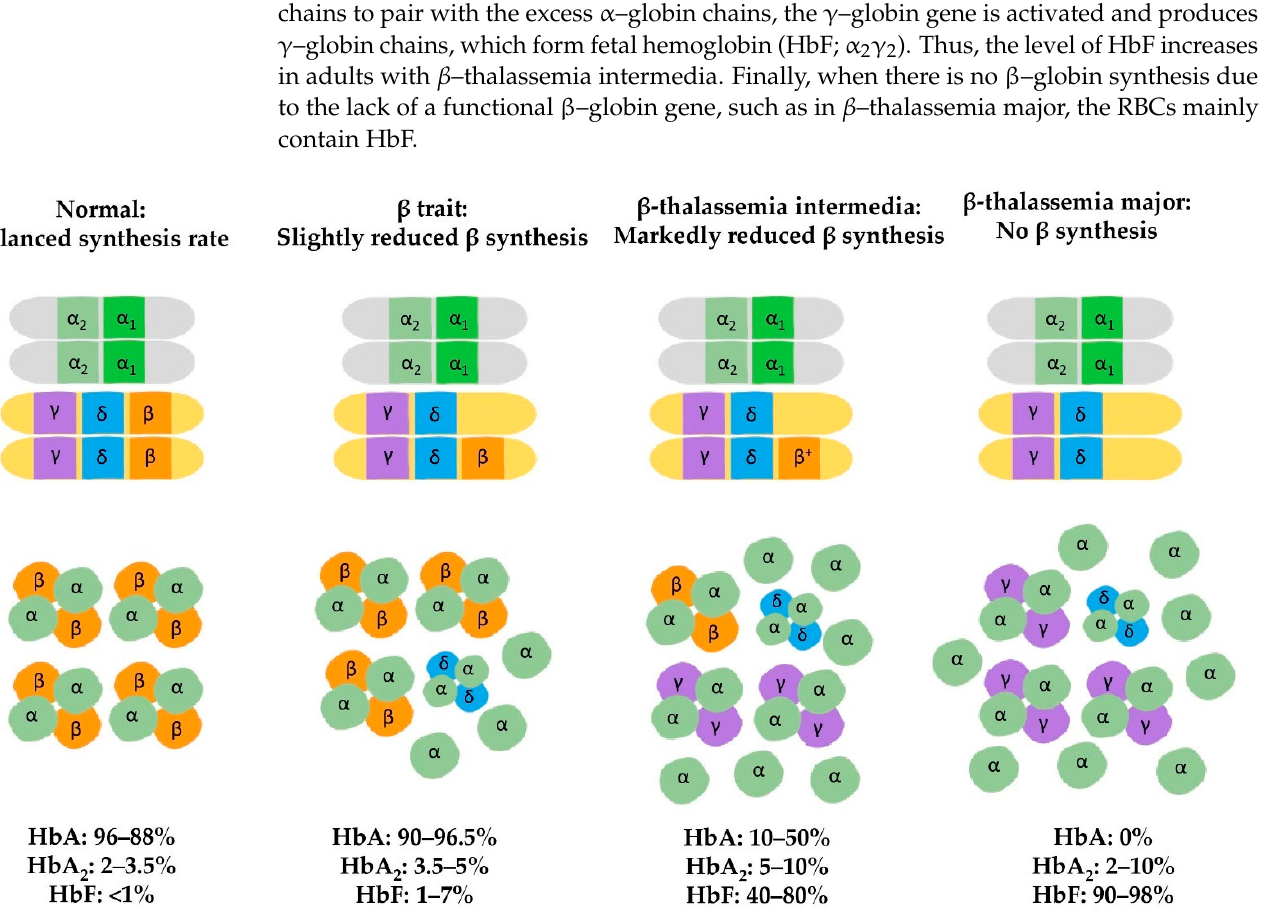
Figure 1. Imbalance of globin tetramers synthesis rate in β –thalassemia due to lack of subsequent genes (adapted from learnhaem.com accessed on 11 February 2021).